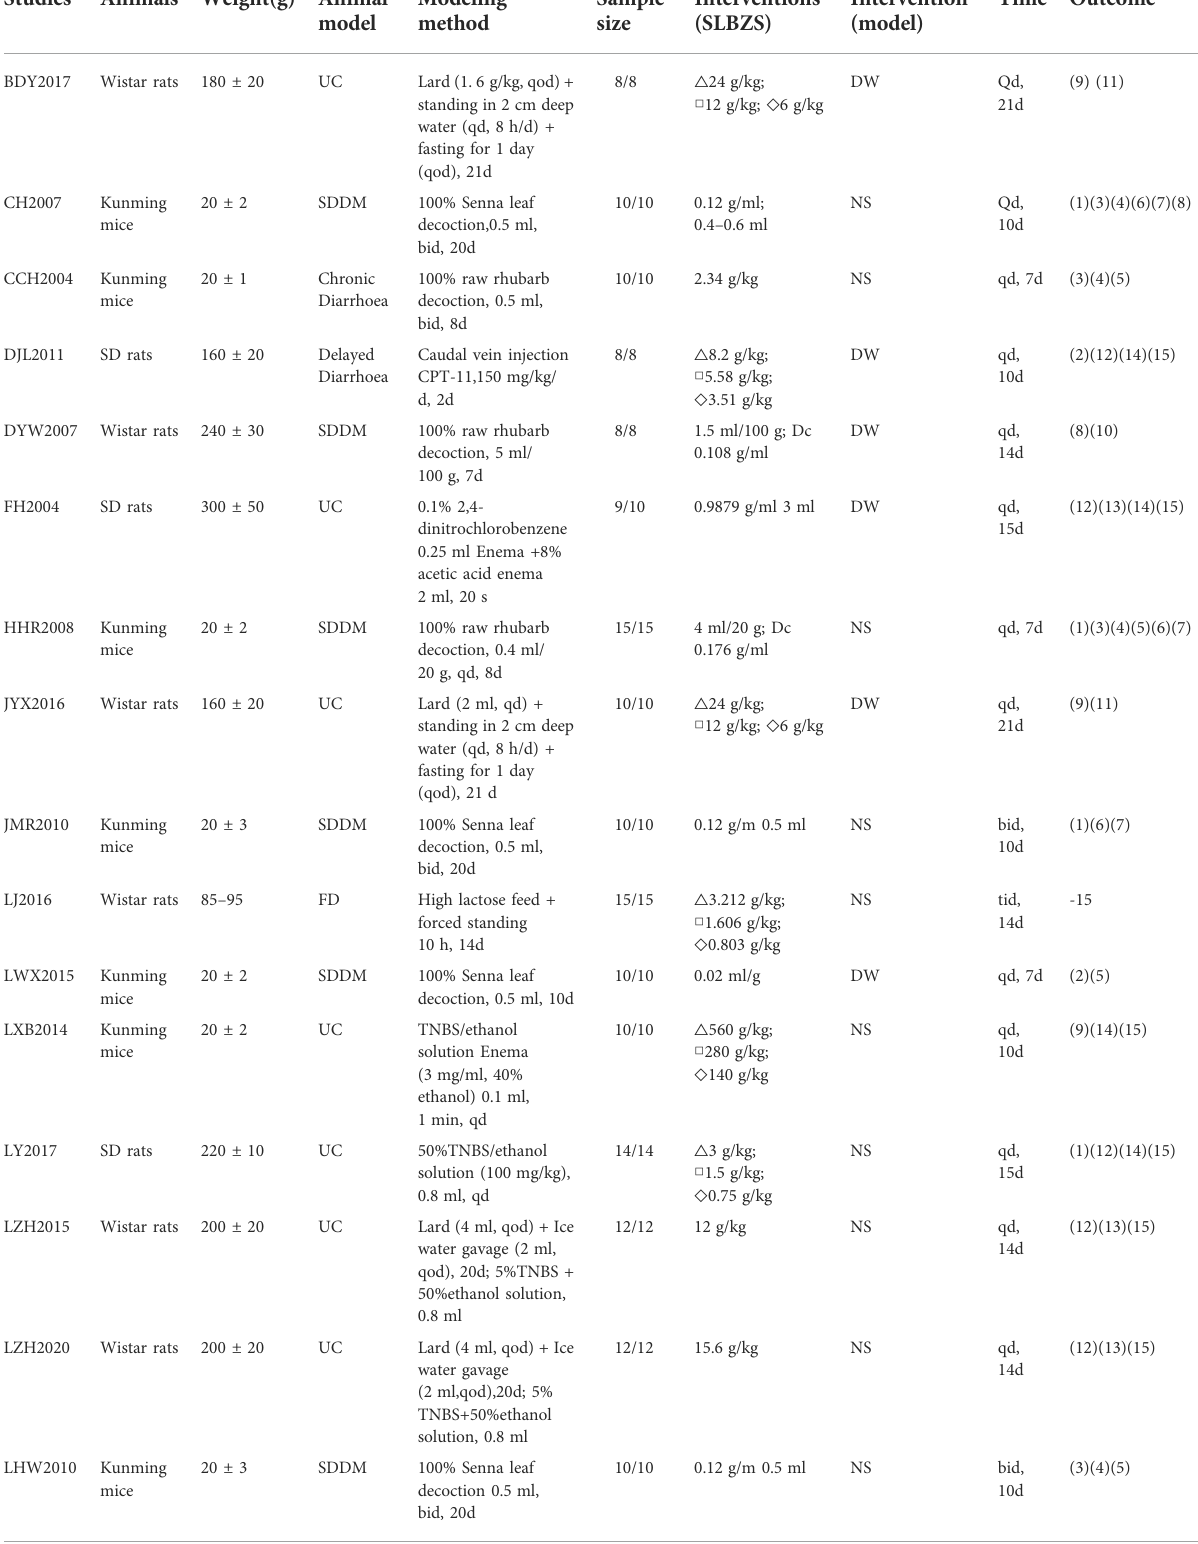
TABLE 1 Characteristics of the included